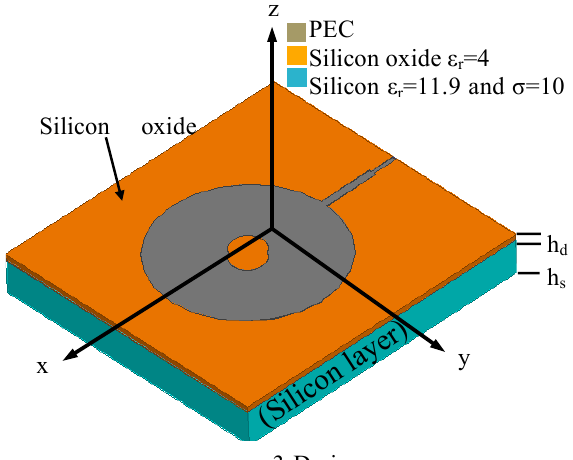
=2.4 mm, W =2.2 mm, h s s =0.115 mm, L s =30 µ m, w =10 µ m, and C=74 µ f t